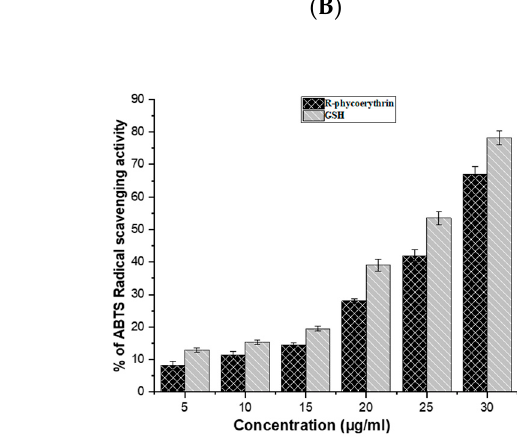
Figure 5. The radical scavenging activity of R-phycoerythrin alpha subunit ( A ) ABTS, ( B ) FRAP assays. R-phycoerythrin alpha subunit exhibited a dose-dependent increase in radical scavenging activity. This demonstrated that the phycoerythrin from P. yezoensis is a source of natural antioxidants that have a potential protective role against oxidative stress and biotechnological applications in the food and pharmaceutical industries. The results suggested that R-phycoerythrin alpha subunit is a relatively powerful antioxidant. The assays were done in triplicate and the results are shown as the mean and standard deviation.